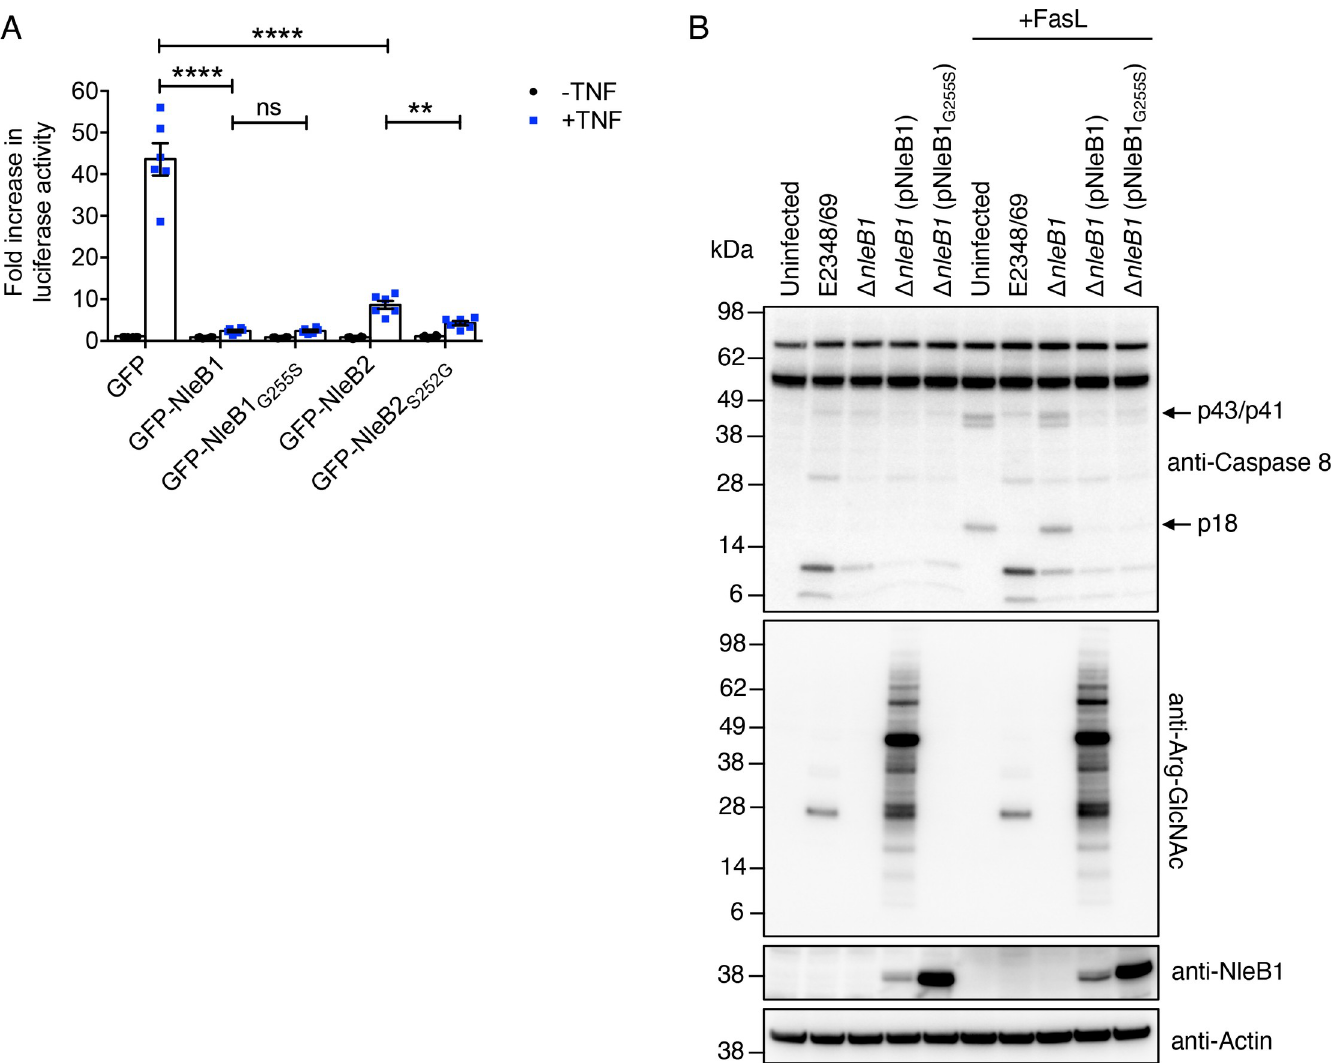
Fig 7. Impact of Arg-glucose post-translational modification on protein function. (A) Fold increase in NF- κ B-dependent luciferase activity in HeLa cells transfected with pEGFP-C2, pGFP-NleB1, pGFP-NleB1 G255S , pGFP-NleB2 or pGFP-NleB2 S252G and either left unstimulated or stimulated with TNF for 16 h where indicated. Results are the mean ± standard error of the mean (SEM) of three independent experiments carried out in duplicate. �� p < 0.01, ���� p < 0.0001, ns (not significant), unpaired, two-tailed t -test. (B) HT-29 cells were either left uninfected or infected with EPEC E2348/69 or derivatives for 3 hours before being stimulated with 20 ng/ml FasL for 2 hours and then lysed and subjected to PAGE and immunoblot with anti-caspase-8 and anti-Arg-GlcNAc antibodies. Anti-Actin antibodies were used as a loading control. Representative immunoblots of at least 3 independent